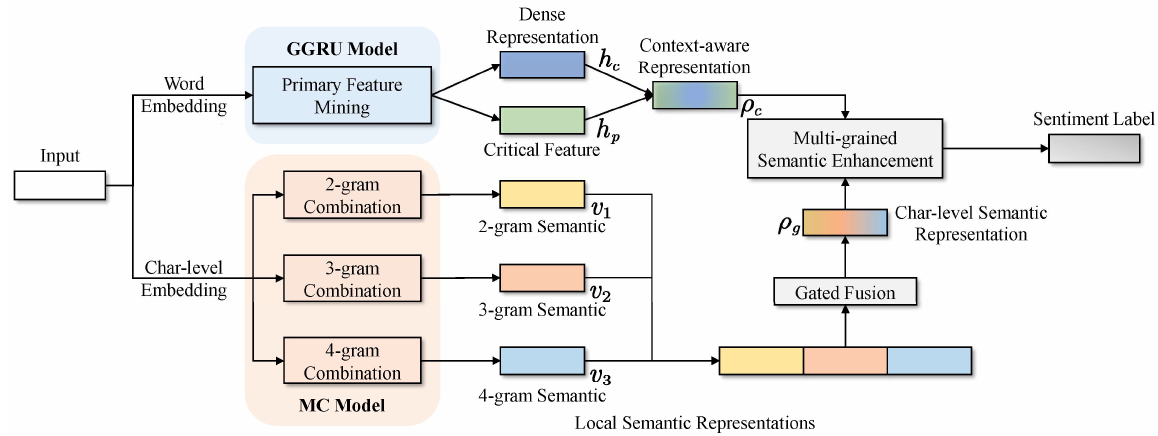
Figure 1. Overall architecture of our proposed hybrid multi-grained lightweight MC-GGRU.